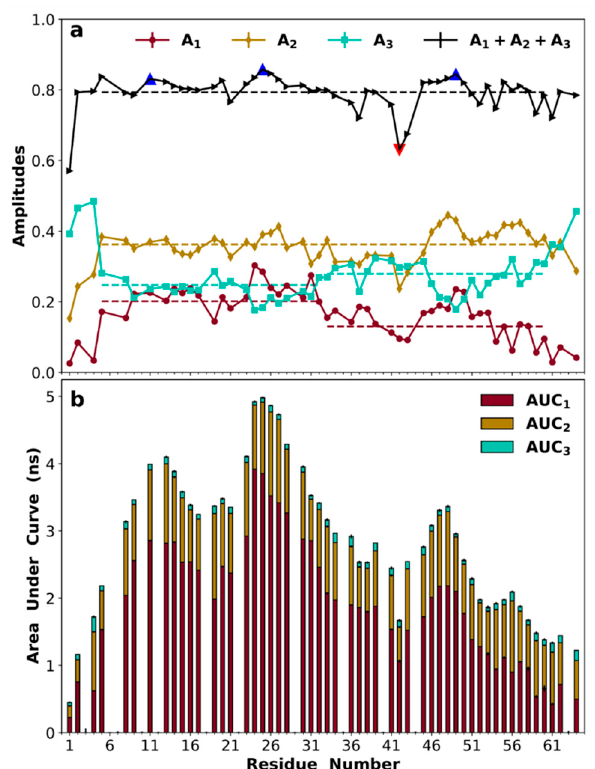
Figure 7. Amplitudes of backbone dynamics on three timescales. ( a ) Amplitudes A 1 , A 2 , A 3 for exponentials with time constants in the 7–17 ns, 1.5–3.5 ns, and 0.2–0.5 ns ranges. The sum of the three amplitudes is also shown, with blue triangles (at Asp11, Arg25, and Arg49) indicating local maxima and a red triangle (at Gly42) indicating a local minimum. Dashed lines show averages over either the entire sequence (residues 5–60) or the two halves (5–32 and 33–60); ( b ) area under the correlation function (AUC). The contributions of the three exponentials are indicated by bars in different colors. Fitting errors for amplitudes and propagated errors for AUC are plotted but are smaller than the size of the symbols.